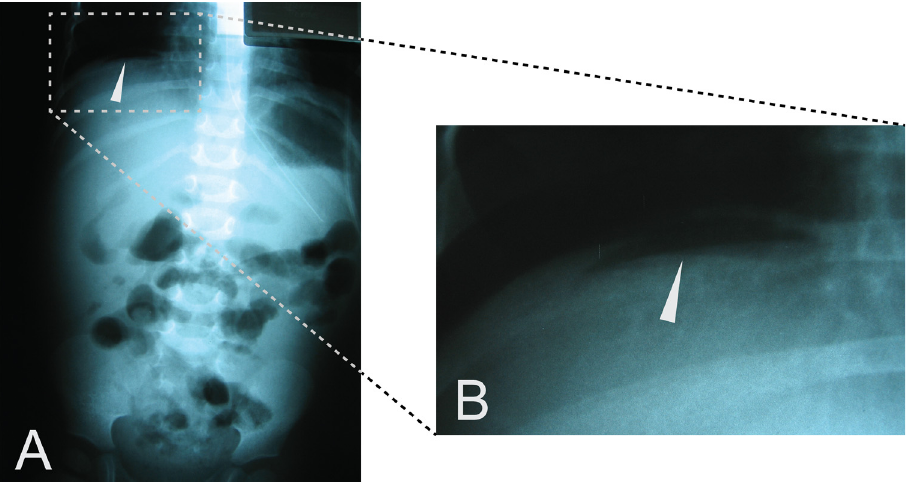
Figure 3. Case No. 2 abdominal X-ray. Imagery was performed 49days following hospitalization. A. Pneumoperitoneum under the right hypochondria (white arrow). B. Focus on the pneumoperitoneum (white